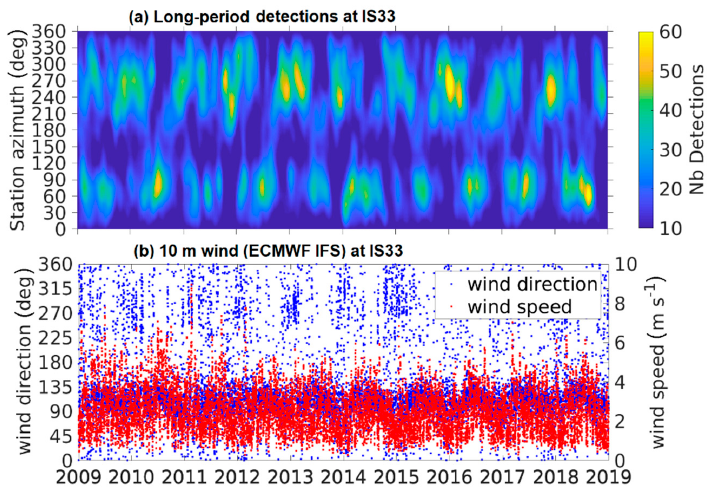
Figure 6. Comparison of ( a ) the long-period GW detections at IS33 with ( b ) the wind speed and direction at the lowest model level of the high-resolution operational analysis that is produced by the Integrated Forecast System (IFS) of the European Center for Medium-Range Weather Forecasts (ECMWF). The detections were evaluated per 30 d and 30°, respectively. In ( b ), the time series interval is 6 h; a sliding average with a window length of 1 d was applied. The PMCC back-azimuth standard deviation of the detected events averages to 0.5° over the shown period. The average correlation coefficient of the events is 0.71 ± 0.1.